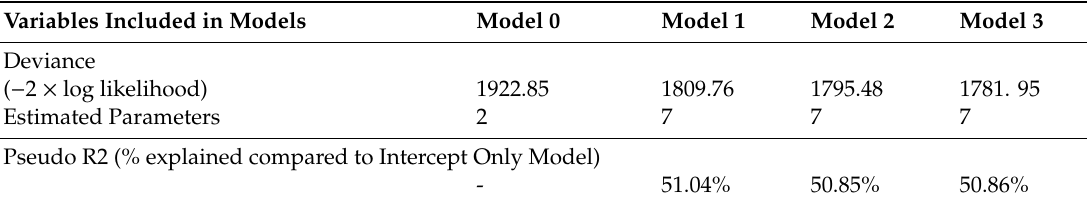
Figure 4. Cross-level three-way interaction effect for drinking behavior (DRSE: Drinking refusal self- efficacy; BPS: Protective behavioral strategies; PEM: Peers’ Enhancement Motivation).